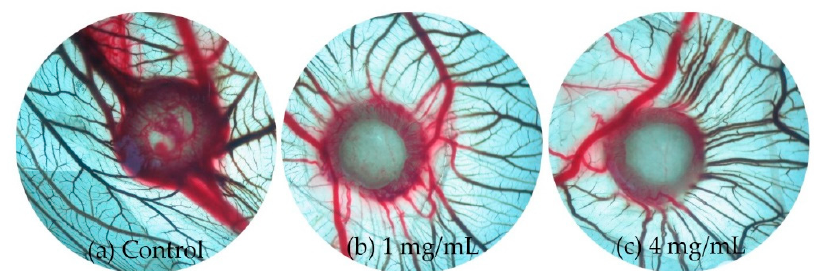
Figure 4. Compound DG-15 promoted angiogenesis in the CAM model with different concentrations: ( a ) Control group; ( b ) 1 mg/mL; ( c ) 4 mg/mL.